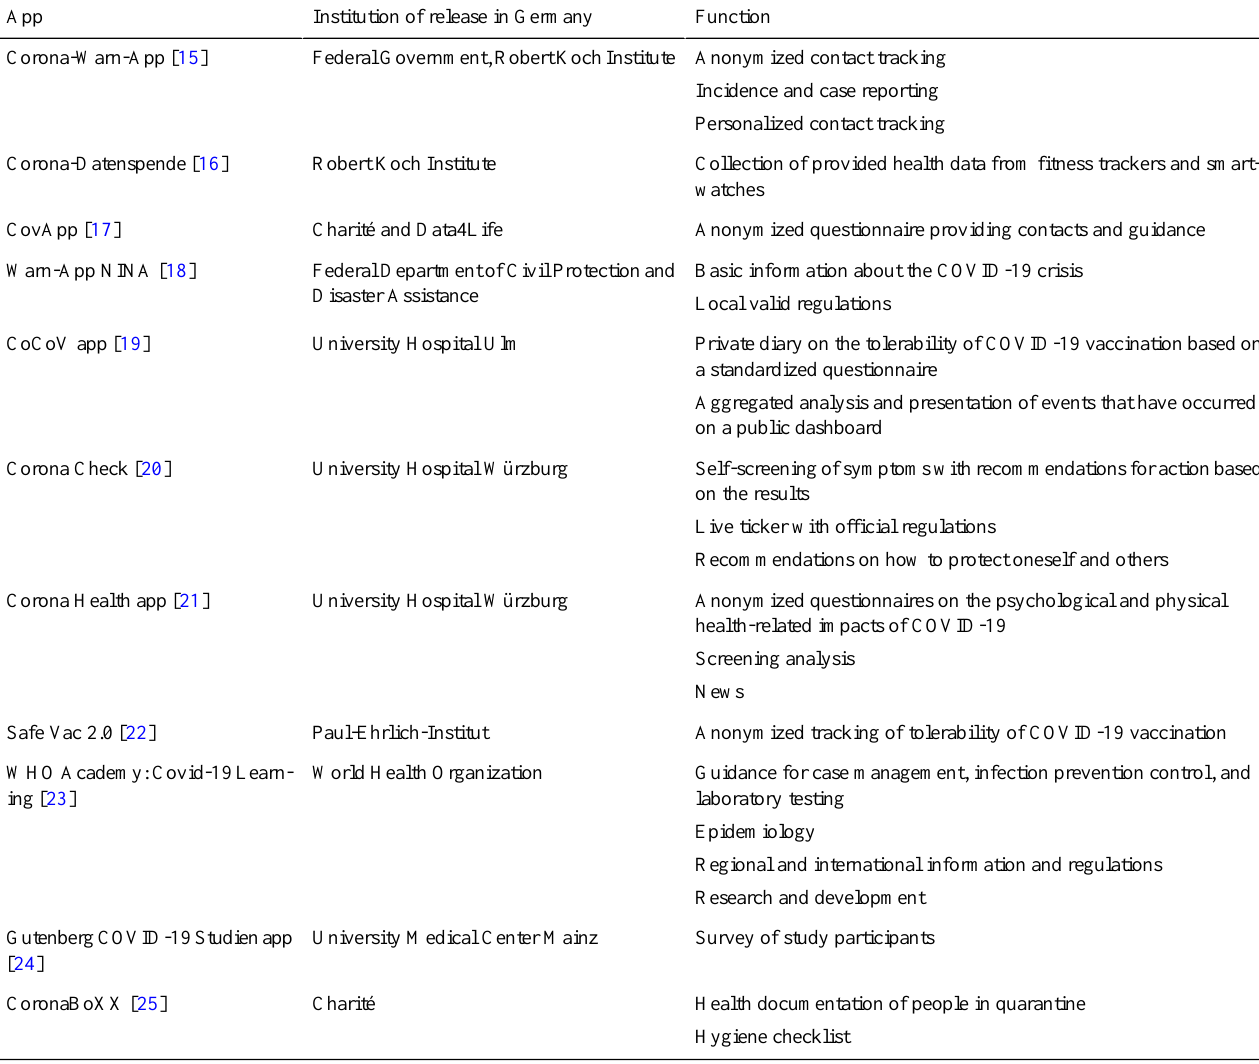
Table 1. Official COVID-19–associated apps released in